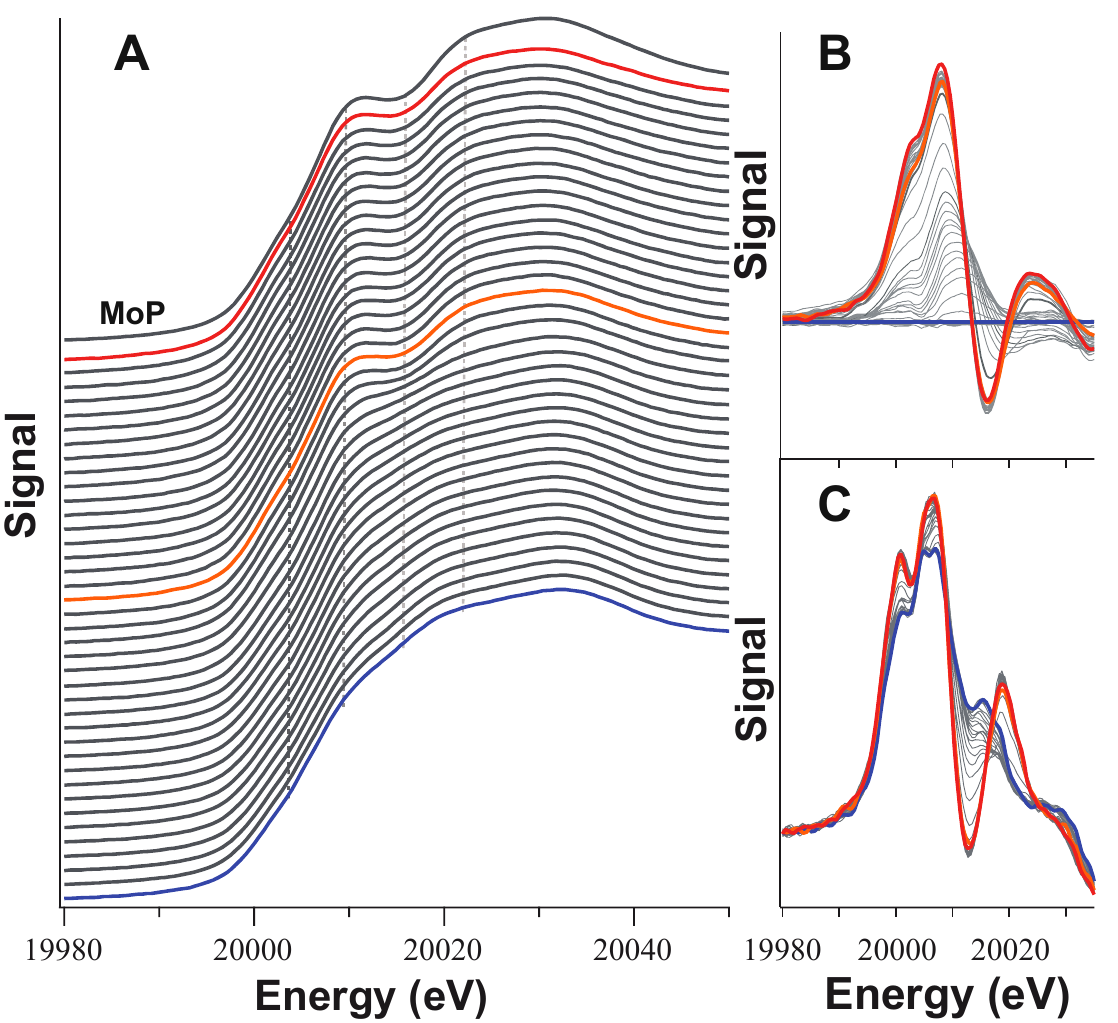
Figure 2. X-ray Absorption Near Edge (XANES) region at Mo K-edge during temperature programmed reduction (TPR). ( A ) XANES region: The XANES spectra were collected from 50 °C up to 700 °C with a 10 °C/min ramp rate and each spectrum was collected in a range of 20 °C; ( B ) series of difference spectra between each XANES collected during the TPR and the spectrum of the as-synthesized nanoparticles. ( C ) First-derivative of the XANES spectra collected during TPR. Blue line: 50 °C; orange line: 450 °C; red curve: 700 °C.